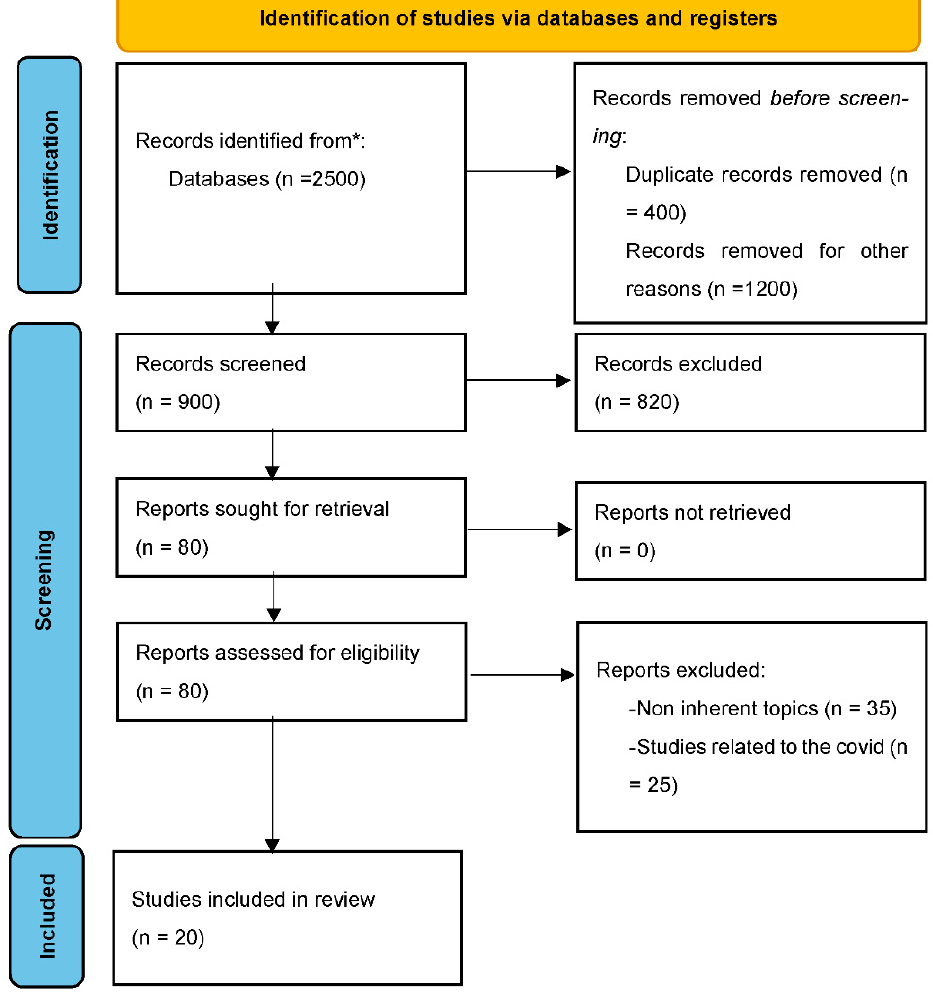
Figure 1. PRISMA 2020 flow diagram for new systematic reviews which included searches of databases and registers only. * Consider, if feasible to do so, reporting the number of records identified from each database or register searched (rather than the total number across all databases/registers).